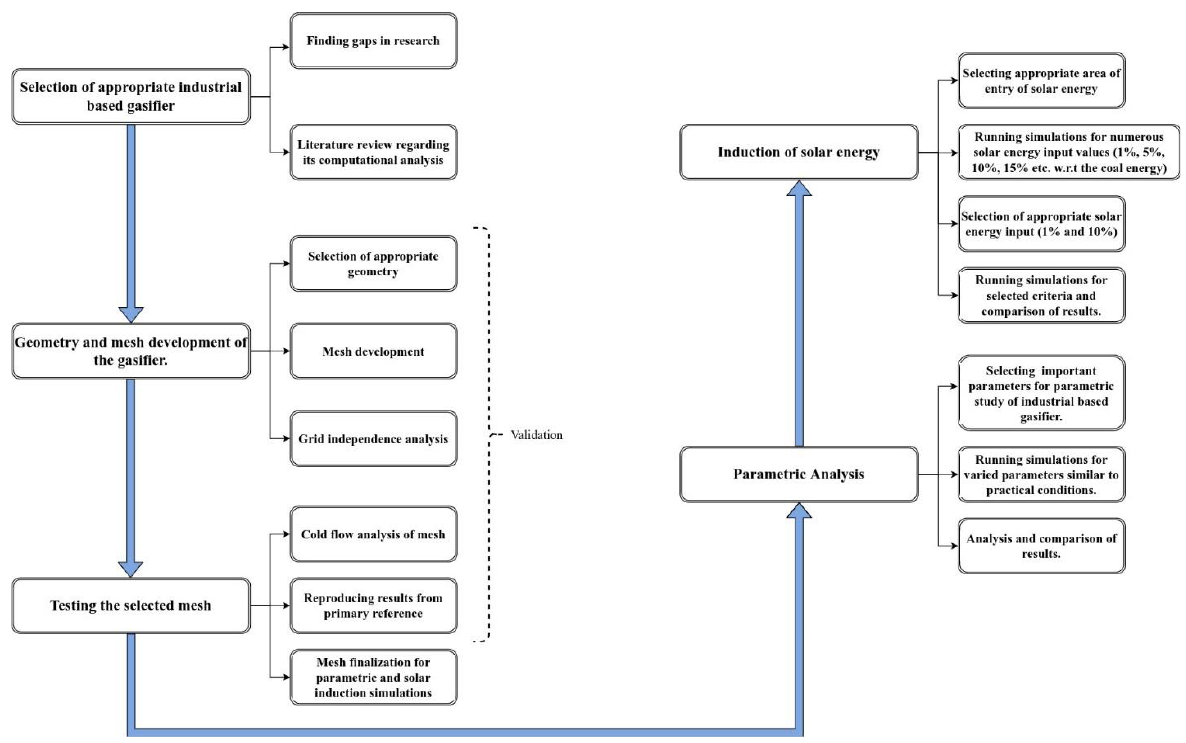
Figure 1. Flowchart of the study.